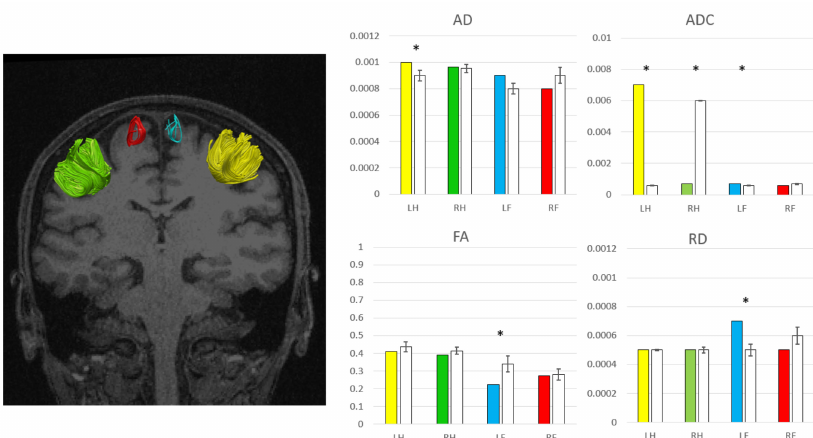
Figure 2. Bilateral hand U-shape fibers: right hand (RH) in green, left hand (LH) in yellow. Bilateral foot U-shape fibers: right foot (RF) in red, left foot (LF) in blue. axial di ff usivity (AD), apparent di ff usion coe ffi cient (ADC), fractional anisotropy (FA), radial di ff usivity (RD) values in the patient (colored bars correspond to the reference U-shapes) and healthy controls (white bars). Significant di ff erences are expressed with “*”.